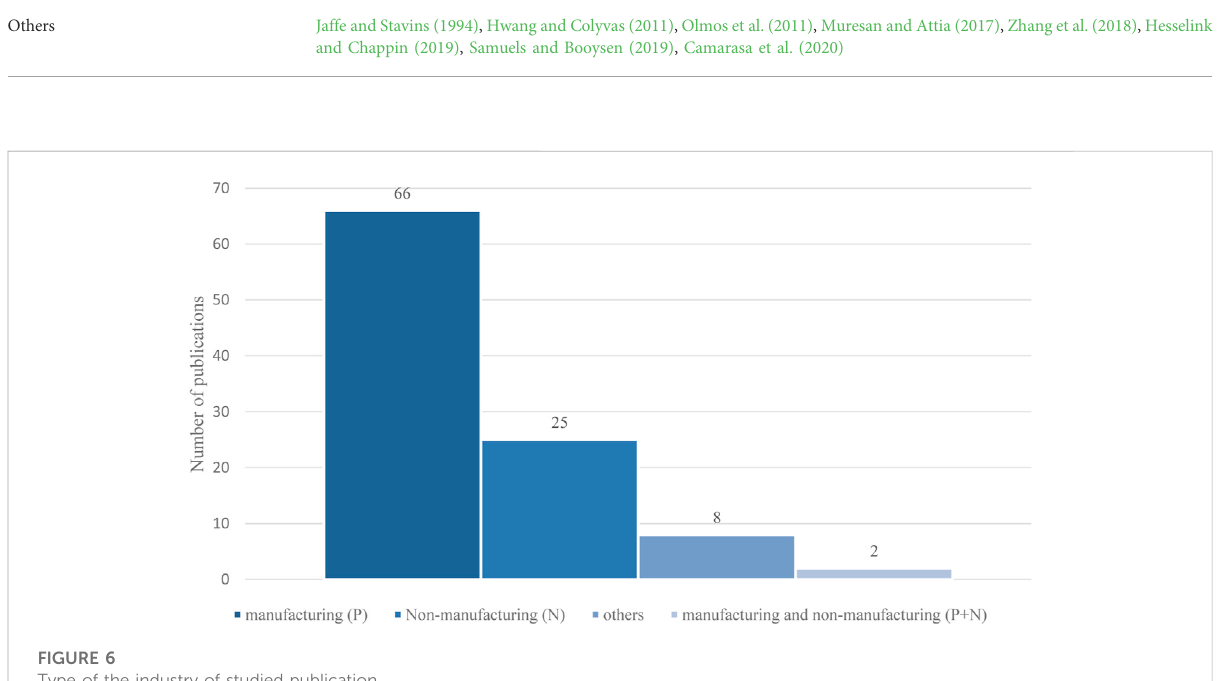
FIGURE 6 Type of the industry of studied